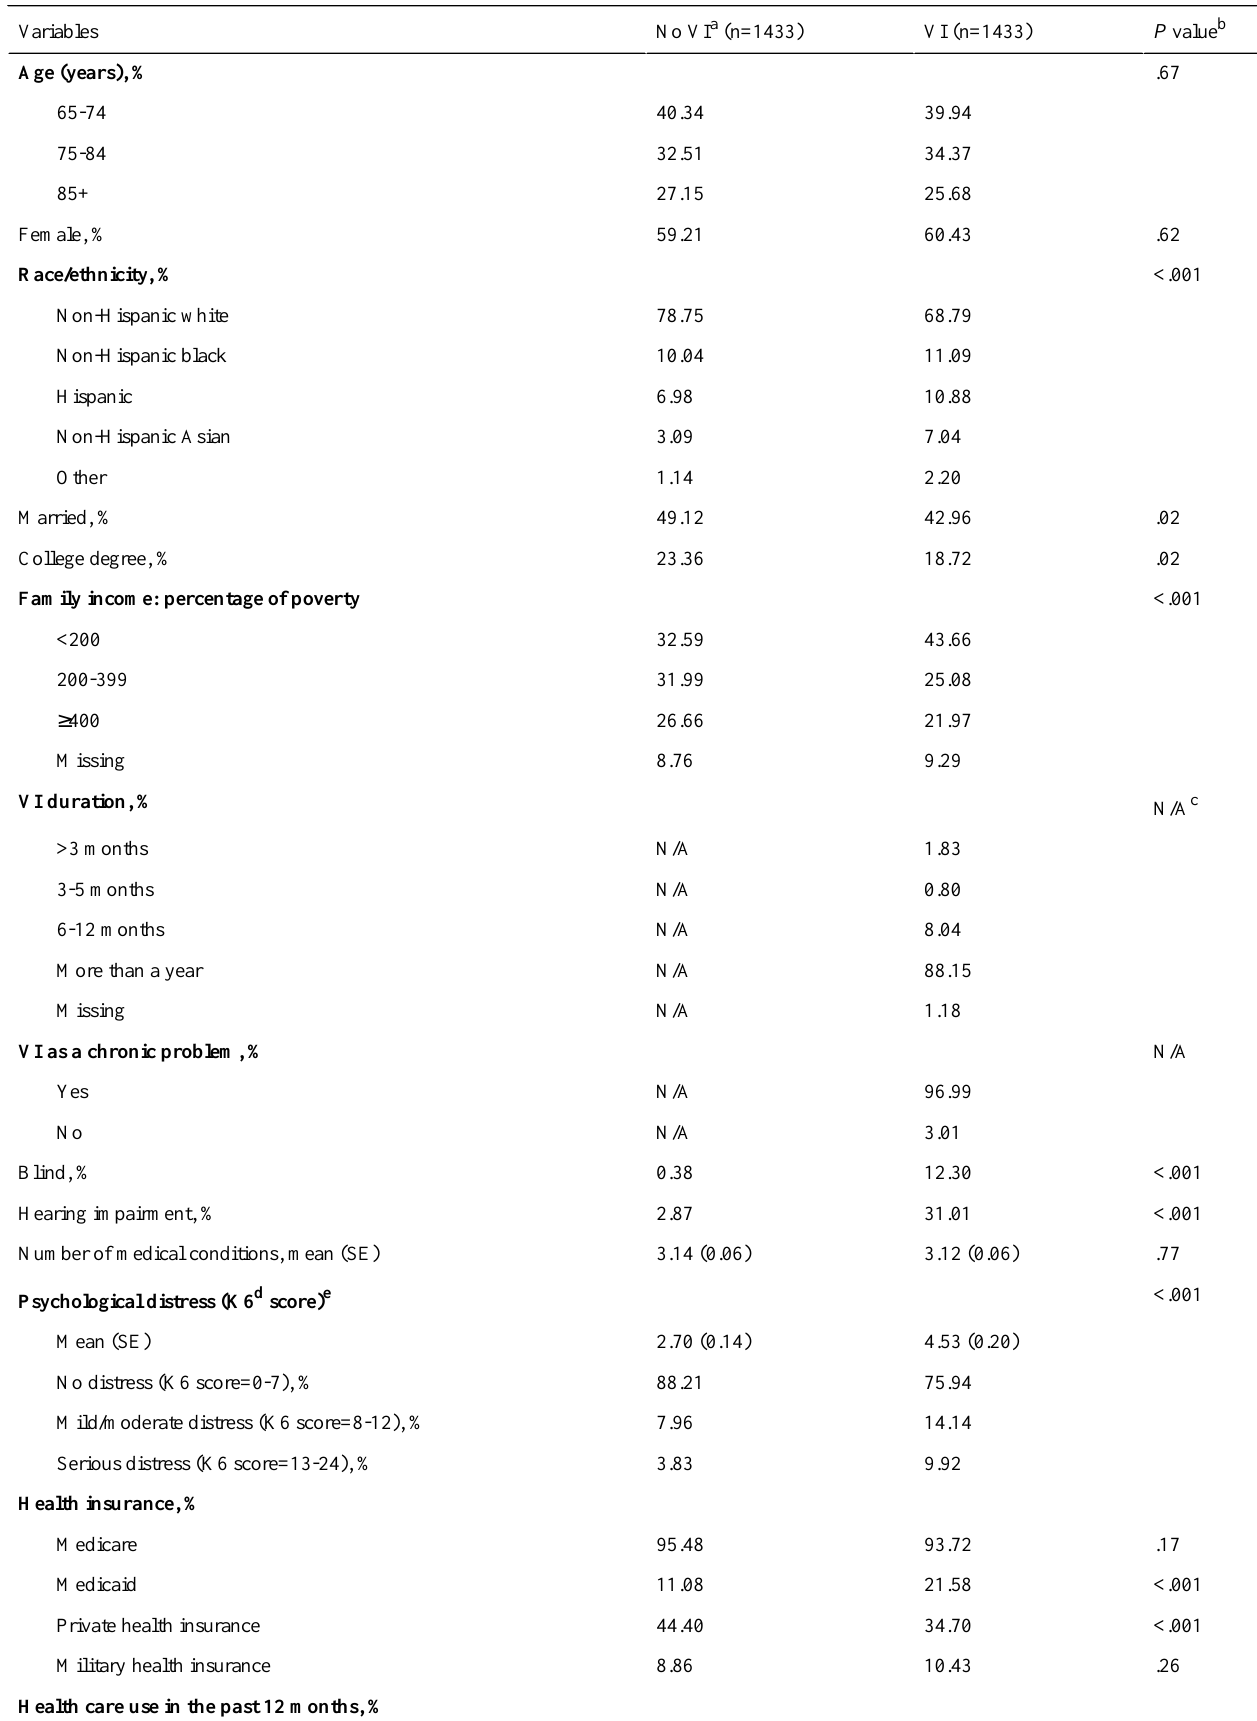
Table 1. Sociodemographic, health insurance, and health care use characteristics of the matched